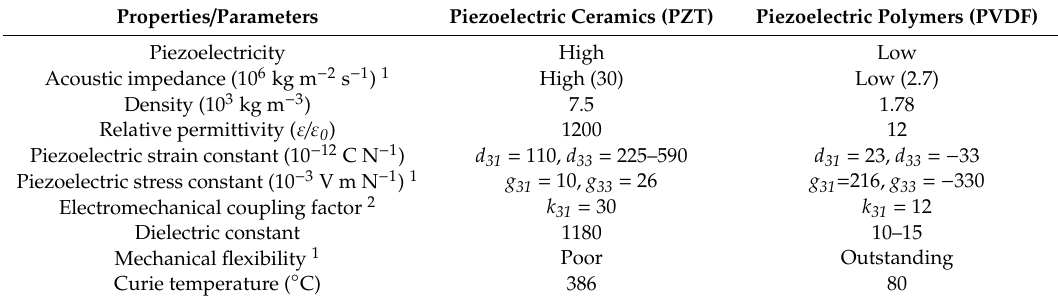
Table 2. Comparison between piezoelectric ceramics and piezoelectric polymers [63].